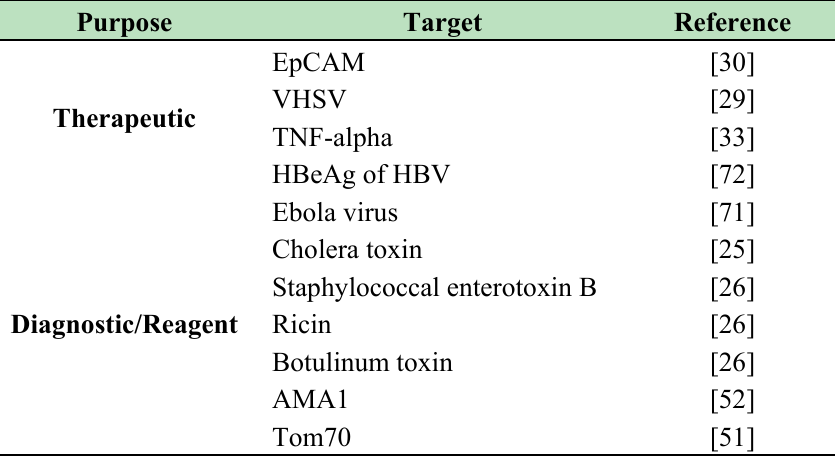
Table 2. VNARs reported in the